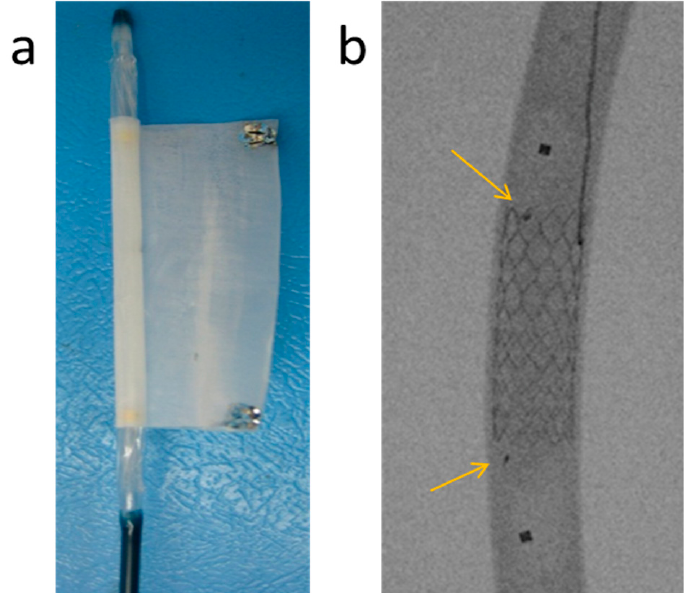
Figure 7. ( a ) Silver markers were placed at the edges of the CLUR sleeve after being mounted on an expandable angioplasty balloon before wrapping it around the balloon; ( b ) Angiographic view of a sleeve welded to the stent inside a Tygon tube using an expandable balloon. The arrows point at the silver markers on the sleeve, while the squares correspond to the balloon markers.